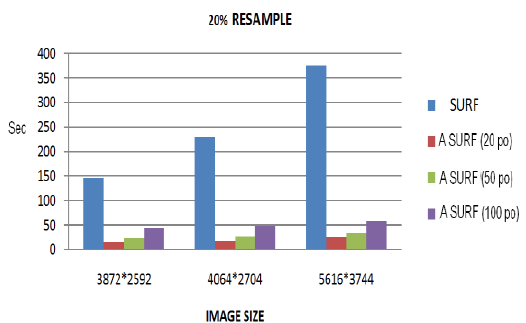
Figure 5. Processing time: SURF VS. Image pyramids based SURF with different number of matched points. (Image size in pixels, po = number of points)